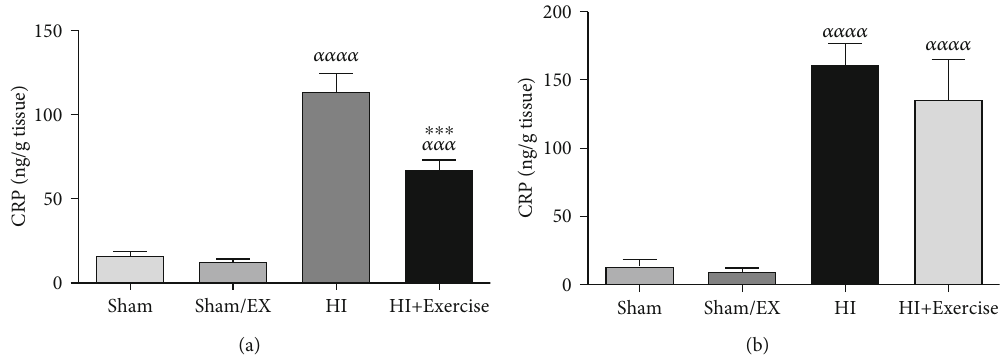
Figure 3: E ff ect of exercise during pregnancy on C-reactive protein (CRP) levels in pups brain after HI of female (a) and male (b) pups. HI: hypoxia-ischemia. ααα P < 0 : 001 , αααα P < 0 : 0001 as compared with the sham and sham/EX. ∗∗∗ P < 0 : 001 as compared with the HI. Data are expressed as the mean ± S : E : M : ( n = 10 ).